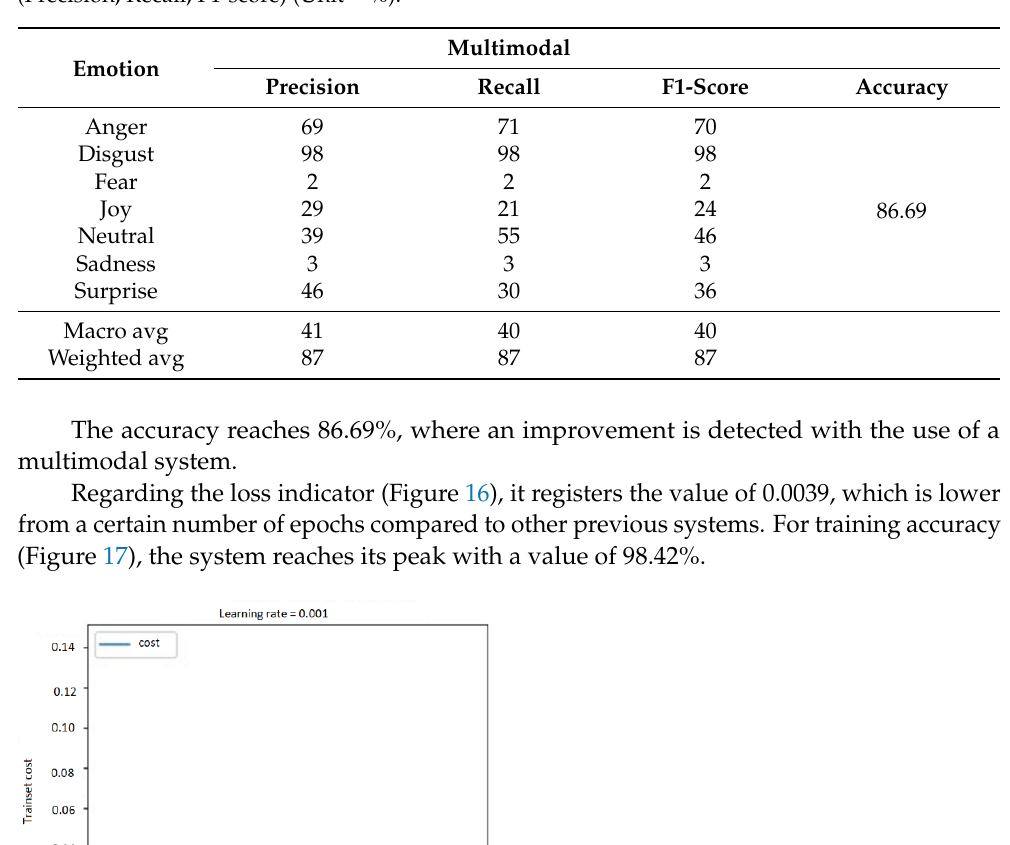
Table 5. Classification report results for the MELD on the multimodal system in the function of (Precision, Recall, F1-score) (Unit = %).